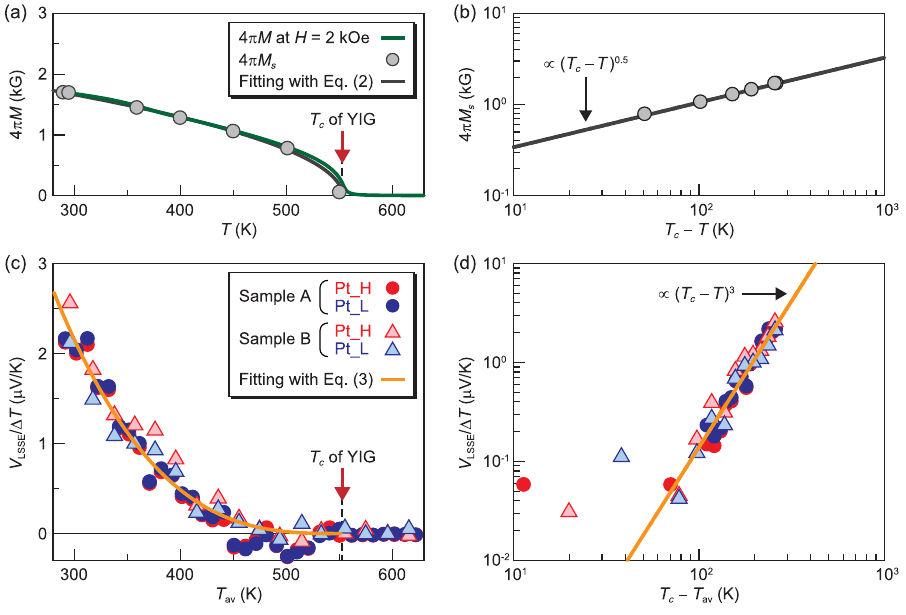
FIG. 3. (a) T dependence of the bulk magnetization 4 π M of the YIG slab. The green curve shows the 4 π M data at H ¼ 2 kOe, measured with a vibrating sample magnetometer. The gray circles show the saturation magnetization 4 π M s of the YIG slab. The gray curve is obtained by fitting the 4 π M s data with Eq. (2). The values of 4 π M s and Curie temperature T c ð¼ 553 K Þ of the YIG slab are estimated by using the Arrott plot method (see Appendix A). (b) Double logarithmic plot of the T c − T dependence of 4 π M s of the YIG = Δ T for two different Pt = YIG = Pt samples A (circles) and B (triangles). The experimental results slab. (c) T dependence of V av LSSE = Δ T data with Eq. (3). shown in Fig. 2 are measured using the Pt = YIG = Pt sample A. The orange curve is obtained by fitting the V LSSE = Δ T for the Pt = YIG = Pt samples A and (d) Double logarithmic plot of the T c − T dependence of V av LSSE